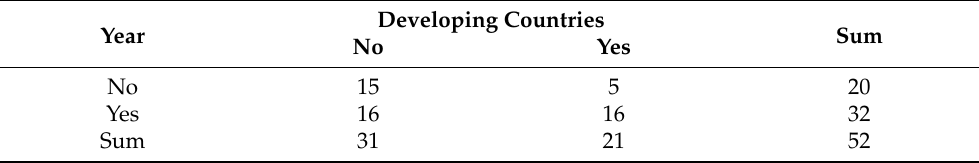
Table 10. Cross-way table for variables: Year and Developing Countries (0.241).